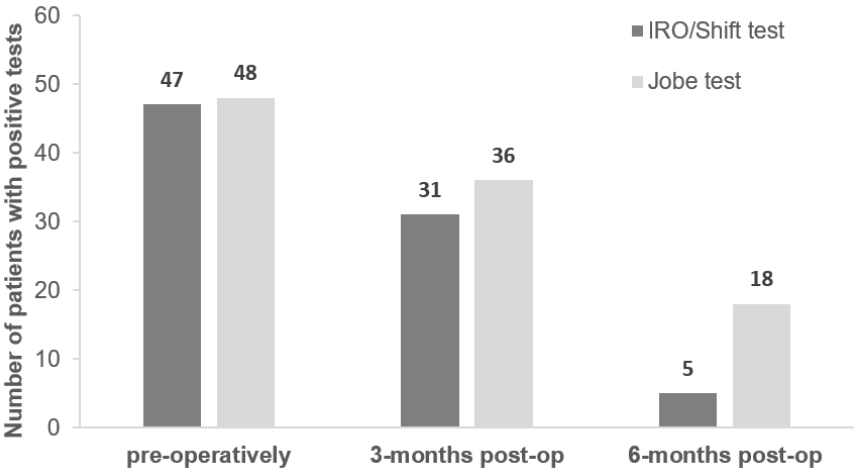
Figure 3. Number of positive IRO/Shift tests and Jobe tests longitudinally. Patients ( n = 51) with arthroscopically confirmed superior rotator cuff lesions. Table 2 . Observed accuracy (Jobe vs. IRO/Shift) depending on examination points for the injured sample ( n = 51).